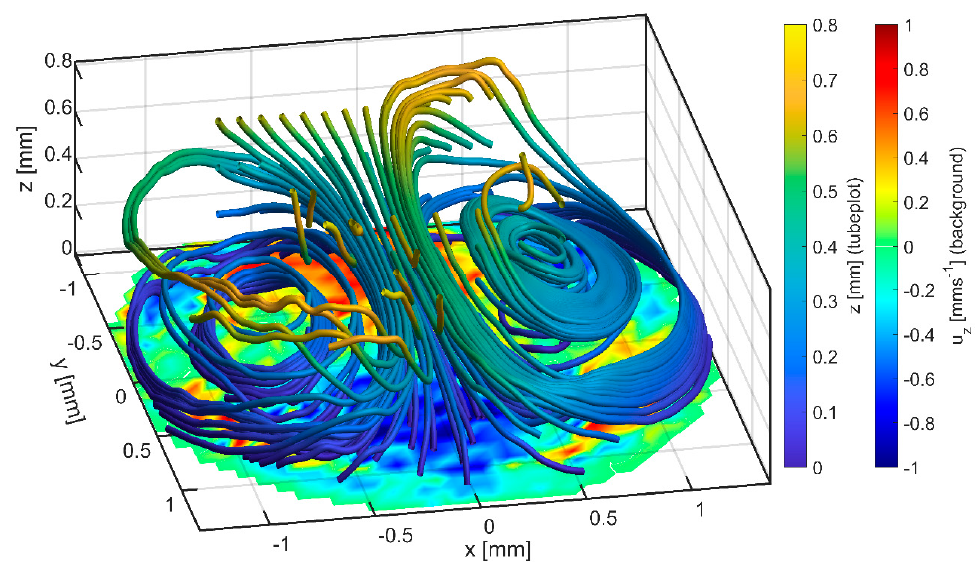
Figure 9. Tube plot showing the 3D velocity profile inside a GB-MBR. The color of the tubes indicates their location in z . At the bottom, u z is color-coded at the lowest measurable plane inside the reactor, which is close to the fluid surface. The data are generated by µ PIV at di ff erent z -positions and are arranged into a 3D array containing velocity information at every point ( x , y , z ). The tube plot is generated using the function stream3() and tubeplot() from MATLAB: from user-defined starting points the tubes are following the 3D velocity field-like particles (of no mass). Hence, tubes have a start and an end, either given by the number of iterations or by the limits of the velocity field. To compare with the model of the Stokes drift, the values of |𝑢| (cid:2922)(cid:2911)(cid:2930) measured at resonances in an GB-MBR with 𝑆 = 60 ° are given in Table 2 in comparison to values calculated by Equation 11 inserted in Equation 1 as: